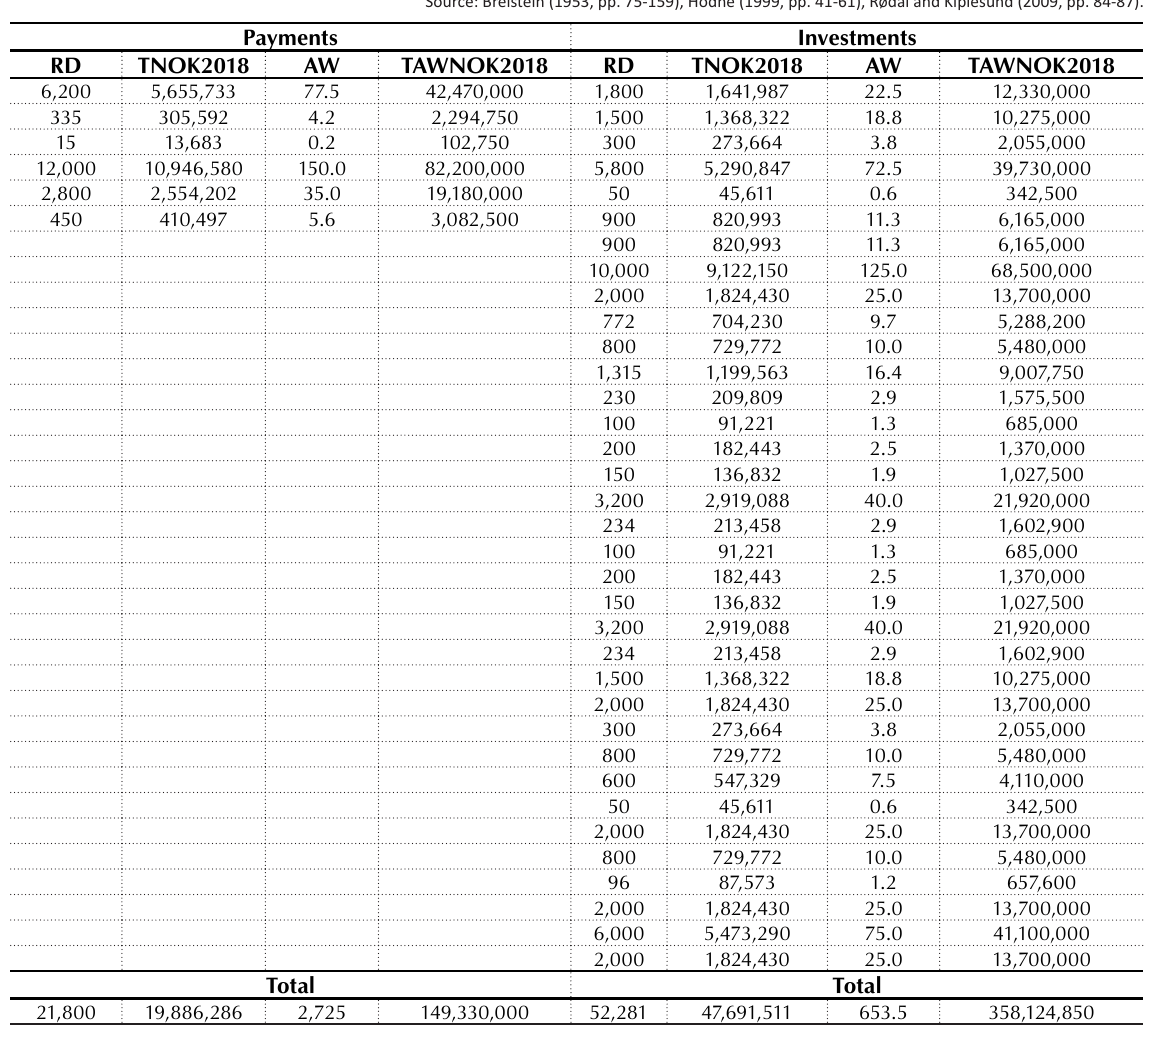
Table 2. Transactions by Hauge in 1804, in